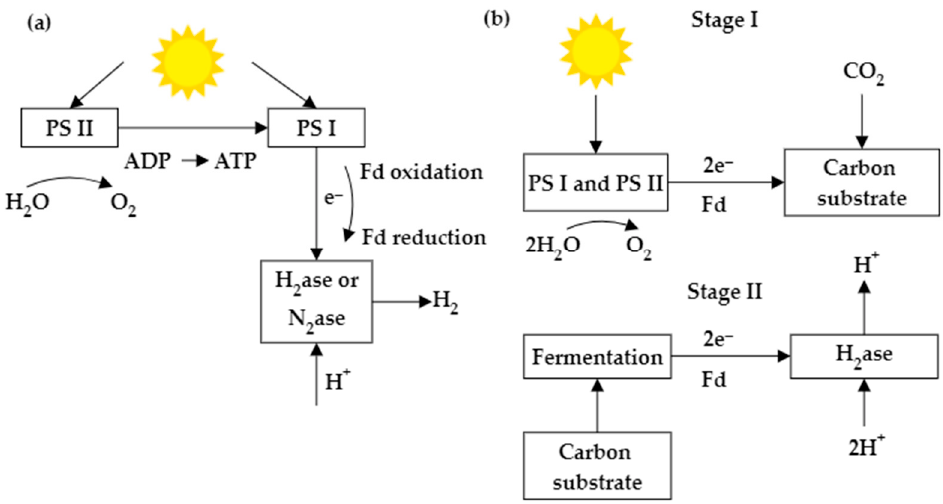
Figure 1. Schematic diagram of bioH 2 production through ( a ) direct biophotolysis and ( b ) indirect biophotolysis.